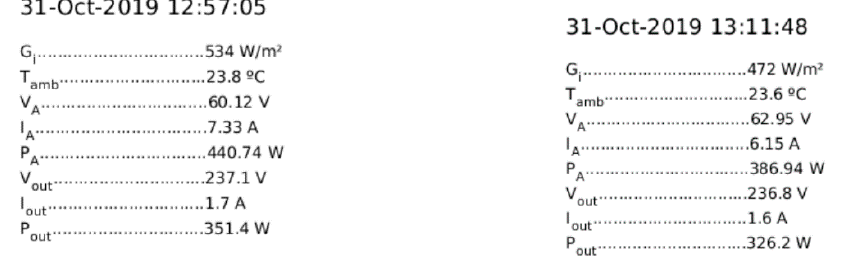
Figure 8. Channel of the Internet of Things (IoT) on thingspeak. Display of instantaneous values. Two graphs are also shown with the output power of the PVS (P A ) and with the active alternating power generated (P OUT ) on a September day (Figures 9 and 10, respectively).